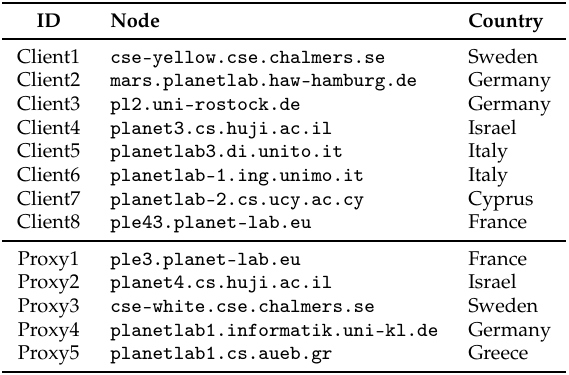
Table 2. Client and proxy distribution in PlanetLab nodes.